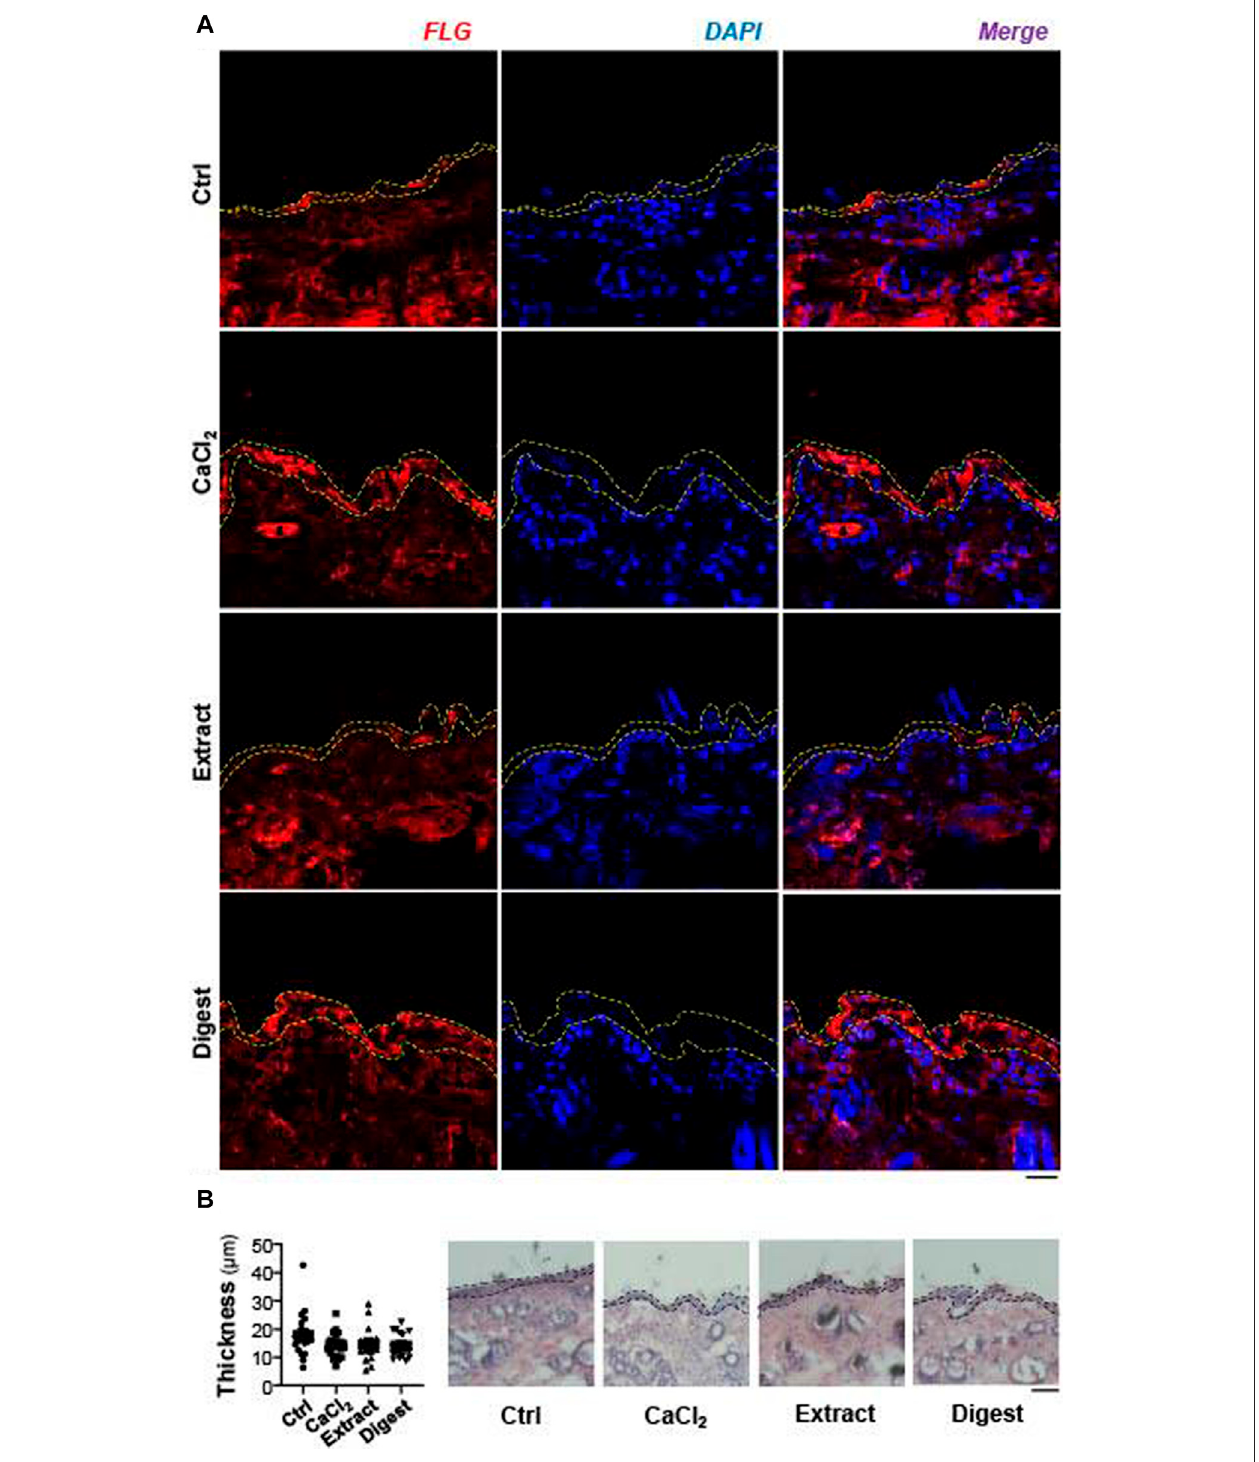
FIGURE 10 | EBN induces fi laggrin in ex vivo mouse skin. (A) The expression of fi laggrin (FLG) protein in 2-month-old mouse dorsal skin ex vivo after 24-h treatments of EBN extract (100 μ g/mL) and EBN digest (100 μ g/mL) were assessed by immuno fl uorescent staining. CaCl 2 at 0.16 mM was adopted as a positive control, n (cid:2) 3. Bar (cid:2) 20 μ m. Yellow dash lines indicate the fl uorescent area of fi laggrin. (B) The epidermal thickness of ex vivo mouse dorsal skin after 24-h treatments of CaCl 2 (0.16 mM), EBN extract (100 μ g/mL)and EBN digest (100 μ g/mL)were assessed by H and Estaining. Black dash lines include epidermis layer (right panel). The quanti fi cation of fi ve randomly selected distance points were assessed for the epidermal thickness (left panel). n (cid:2) 3. Bar (cid:2) 100 μ m.